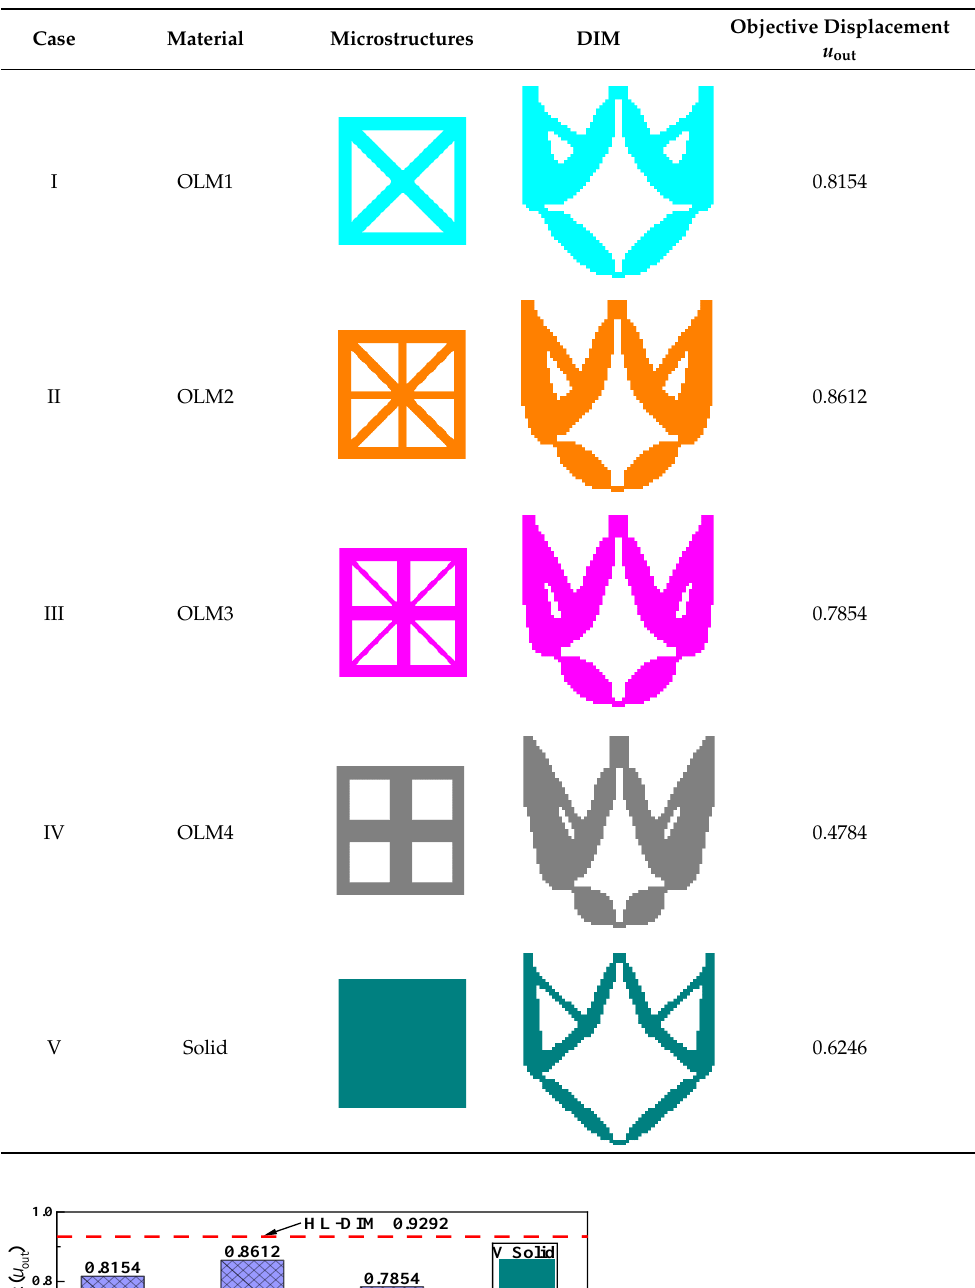
Table 4. Uniform DIMs with different lattice microstructures.